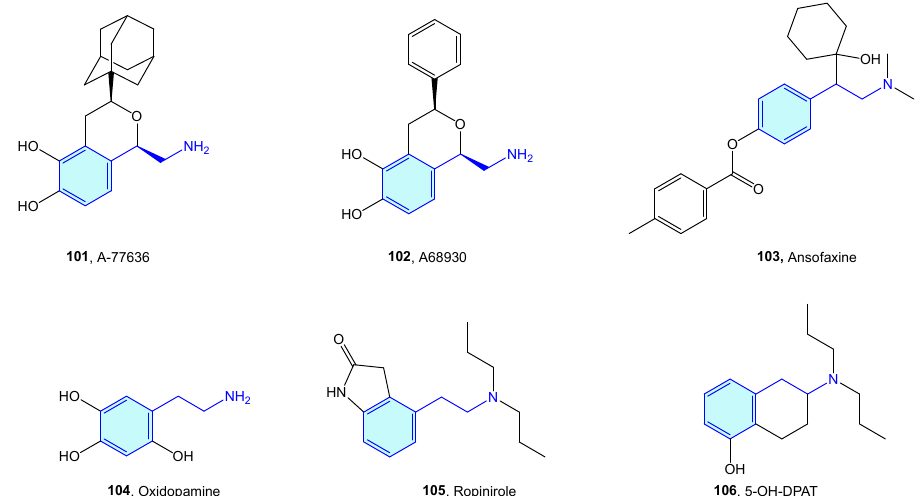
Figure 12. 2-Phenylethyl-based dopamine receptor medicinal chemistry leads. Figure 12. 2‑Phenylethyl‑based dopamine receptor medicinal chemistry leads.